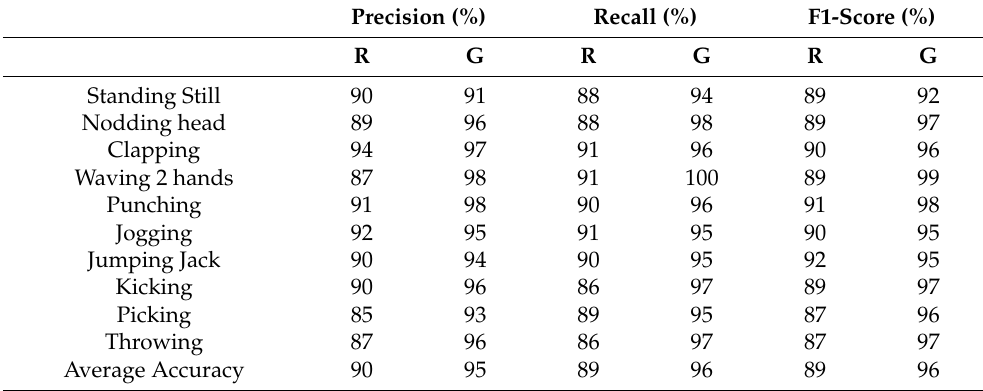
Table 6. RGB base (R) and Growth (G) Performance Analysis on WVU